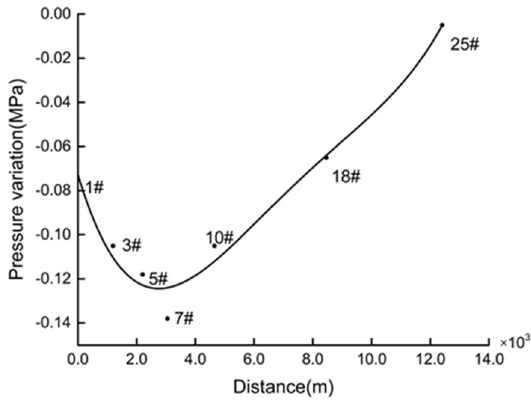
Figure 14. Pressure change after the burst.